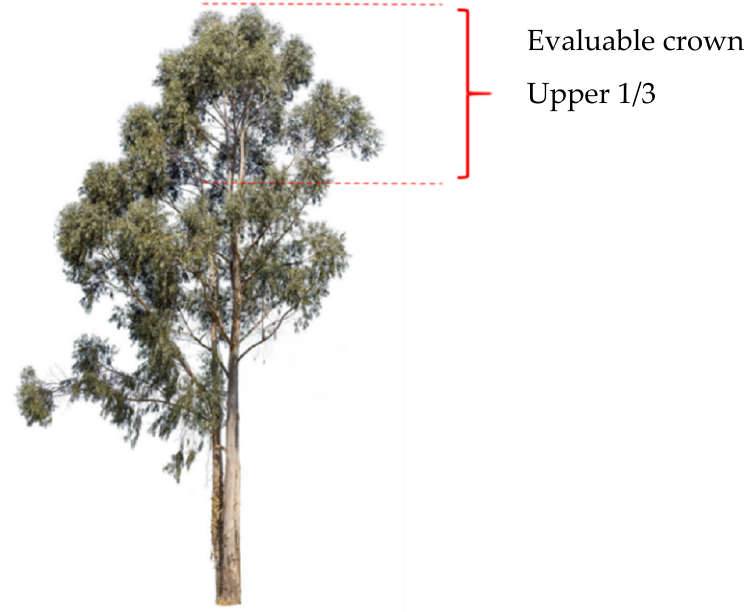
Figure 3. Diagram of the upper third of the crown of Eucalyptus globulus where the degree of defo-